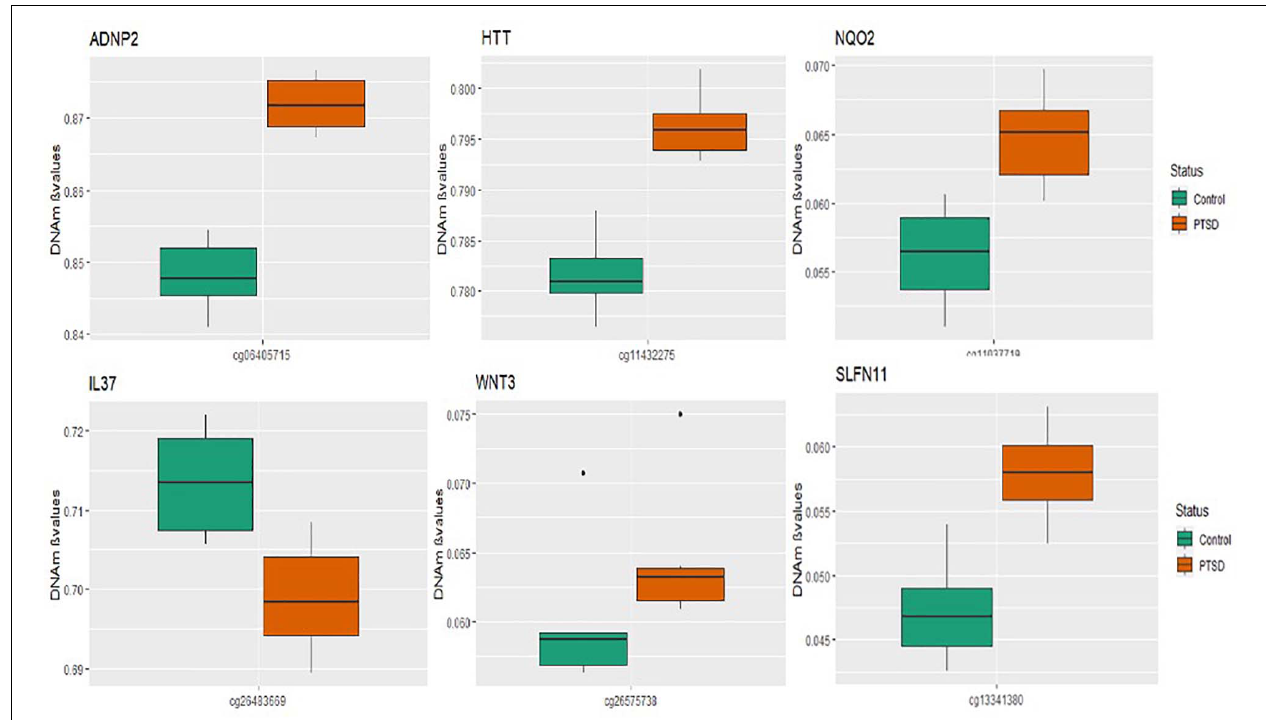
FIGURE 3 | Box plots of most significant genes: boxplots of genes significantly associated with PTSD ( p -value < 5.77 × 10 - 8 ) in the MZ twins is depicted. The mean DNA methylation is higher in PTSD than in controls for all the genome wide significant genes except for the IL37 locus probe.